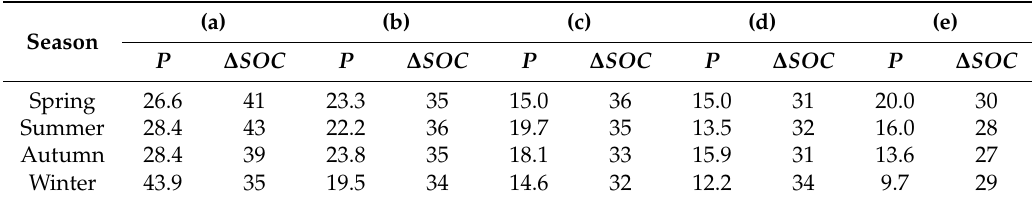
Table 5. The probability of each type of typical day and the change of the SOC of BESS ( ∆ SOC ).